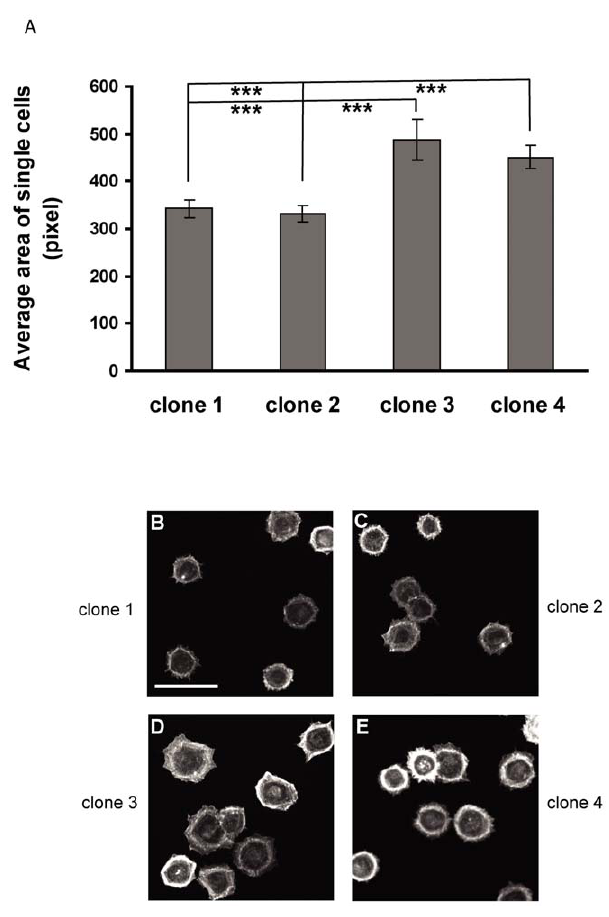
Figure 7. In the absence of SH3PXD2B cell spreading is impaired. ( A–E ) The HeLa clones described in Figure 6 were seeded onto fibronectin-coated coverslips, fixed and permeabilized after 30 minutes and stained with TRITC-Phalloidin. Cell surface area was calculated based on images of over 200 cells using the ImageJ 1.38x software. Average size of the cells for two SH3PXD2B-negative (clones 1 and 2) and two control cell lines (clones 3 and 4) is plotted ( A ). Panels B- E show representative images of poorly spread ( B and C ) and well spread ( D and E ) HeLa cells. Error bars represent the Standard Error of the Mean, SEM. ***: p , 0.001, n=6 Bar represents 20 m m.